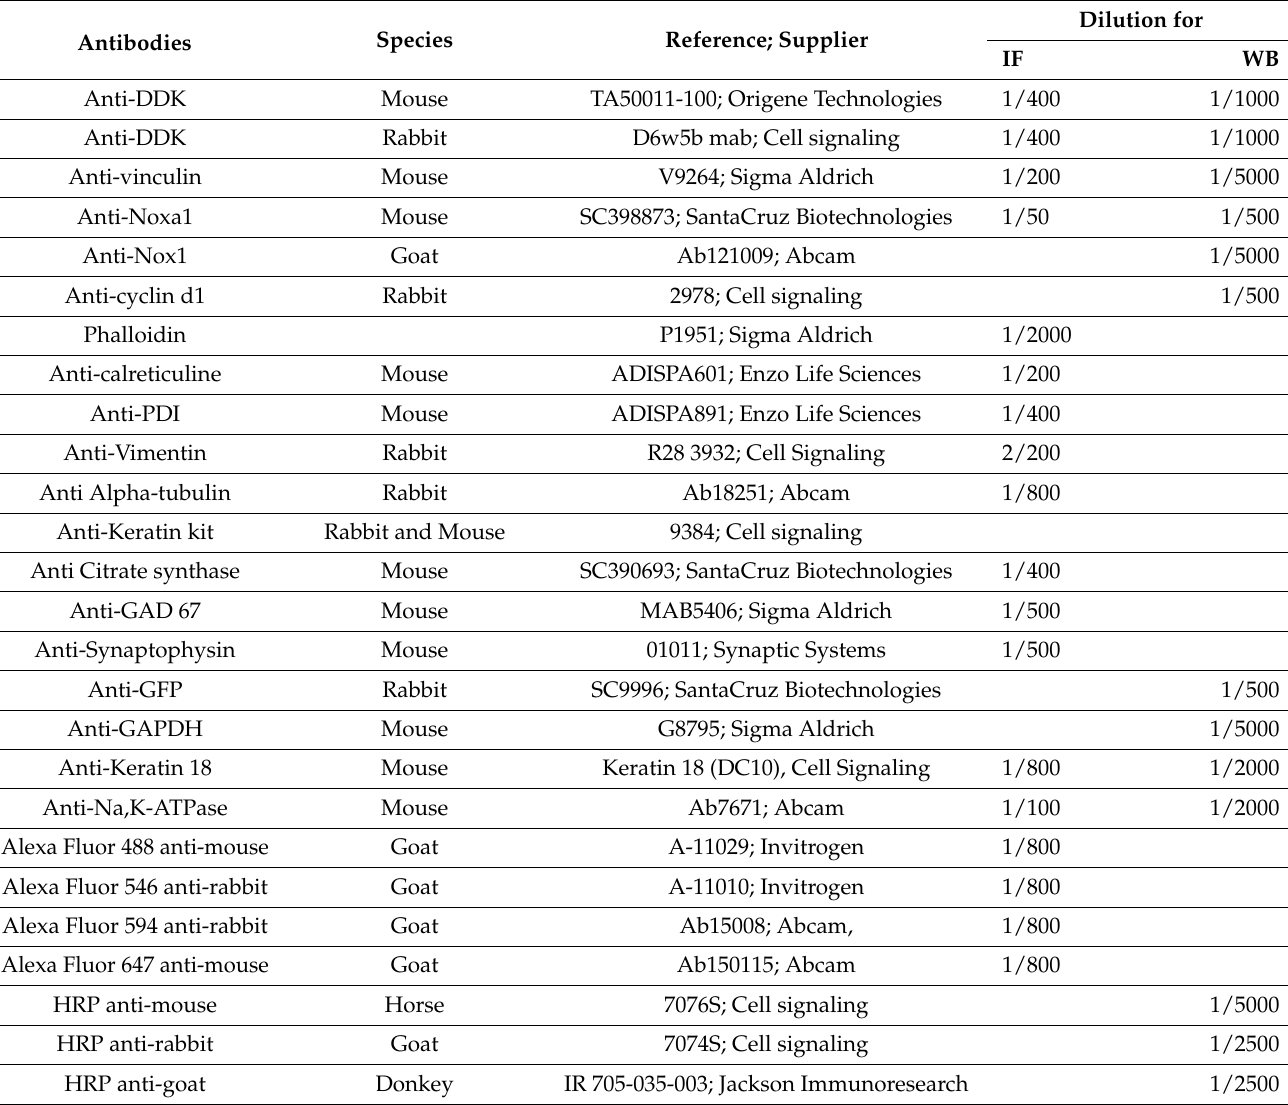
Table 1. Antibodies references used during the